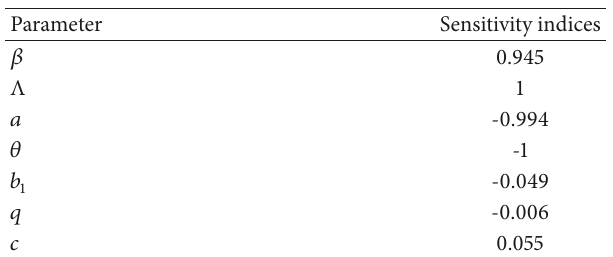
Table 3: The sensitivity indices of 𝑅 02